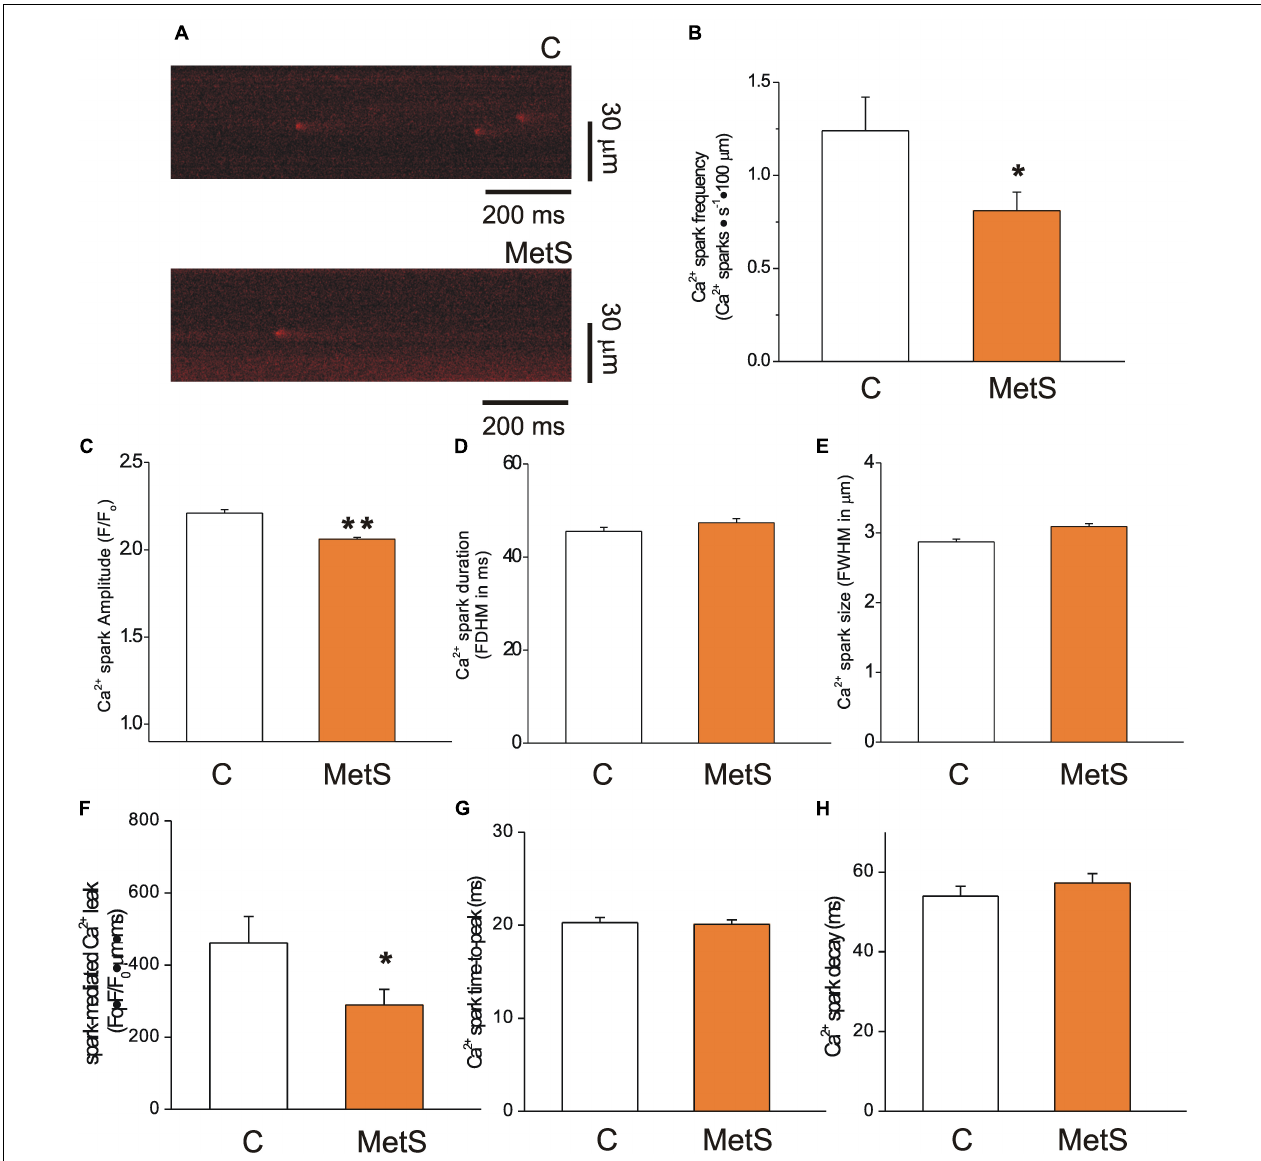
FIGURE 2 | Reduced spark-mediated Ca 2 + leak in cardiomyocytes of MetS animals. Representative line-scan images (2 ms/line) of spontaneous Ca 2 + sparks recorded in Fluo 3-loaded cardiomyocytes from control (C) and MetS hearts (A) . Bar graphs comparing the average frequency ( B , events/s · 100 µ m), amplitude ( C , F/F 0 ), duration ( D , FDHM in ms), size ( E , FWHM in µ m), spark-mediated Ca 2 + leak ( F , reported as spark frequency ∗ spark mass), time-to-peak ( G, in ms), and decay time ( H, in ms) of Ca 2 + sparks in control ( white bars ; n = 907 events recorded in 41 cells) and MetS ( orange bars ; n = 1050 events recorded in 50 cells) cardiomyocytes. ∗ P < 0.05; ∗∗ P < 0.001 respect to control